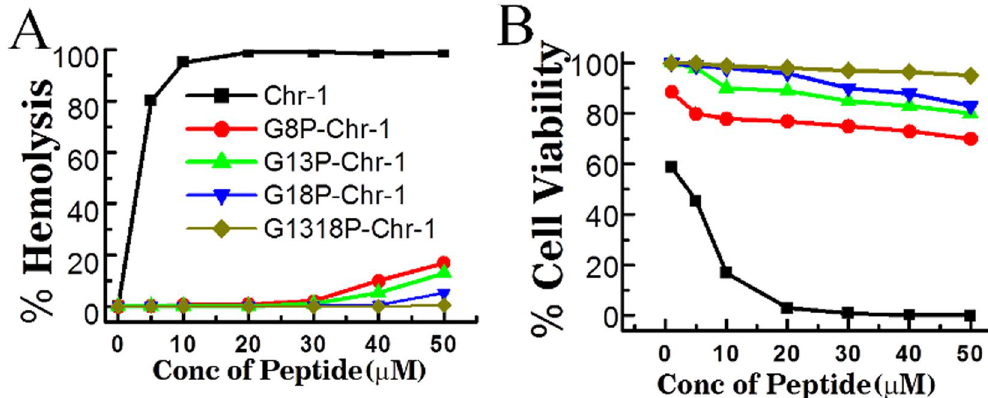
Figure 1. Cytotoxicity of Chr-1 and its analogs. ( A ) and ( B ) Shows dose-dependent cytotoxicity of Chrysophsin-1 and its variants (hemolytic activity) and NIH-3T3 cells (MTT assay for cell viability) respectively.